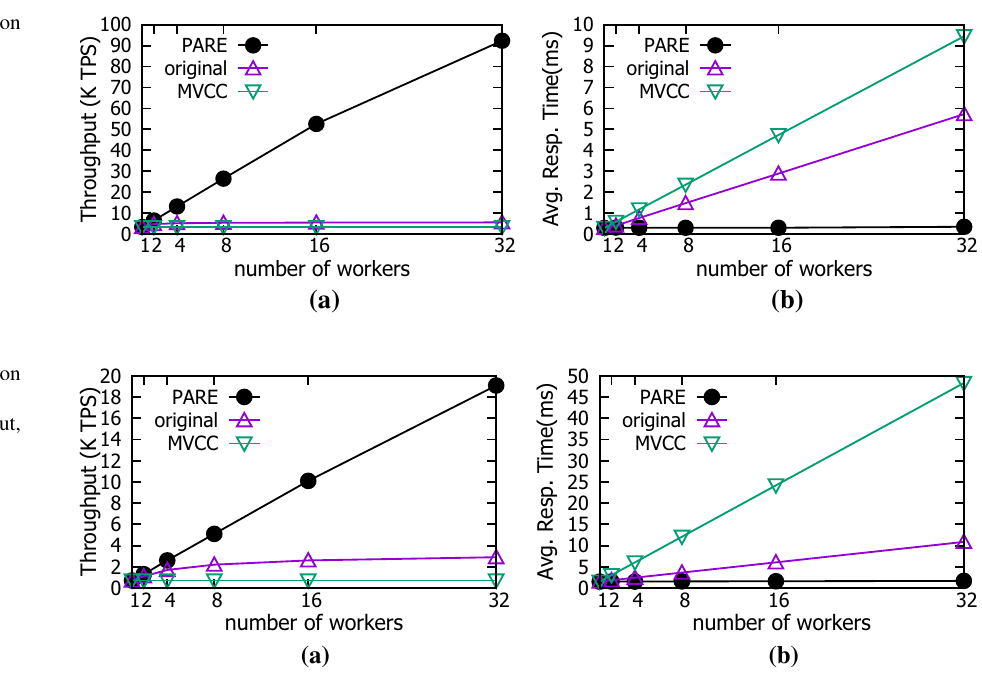
Fig. 4 Performance comparison under highly contended HFT workloads. a Throughput, b